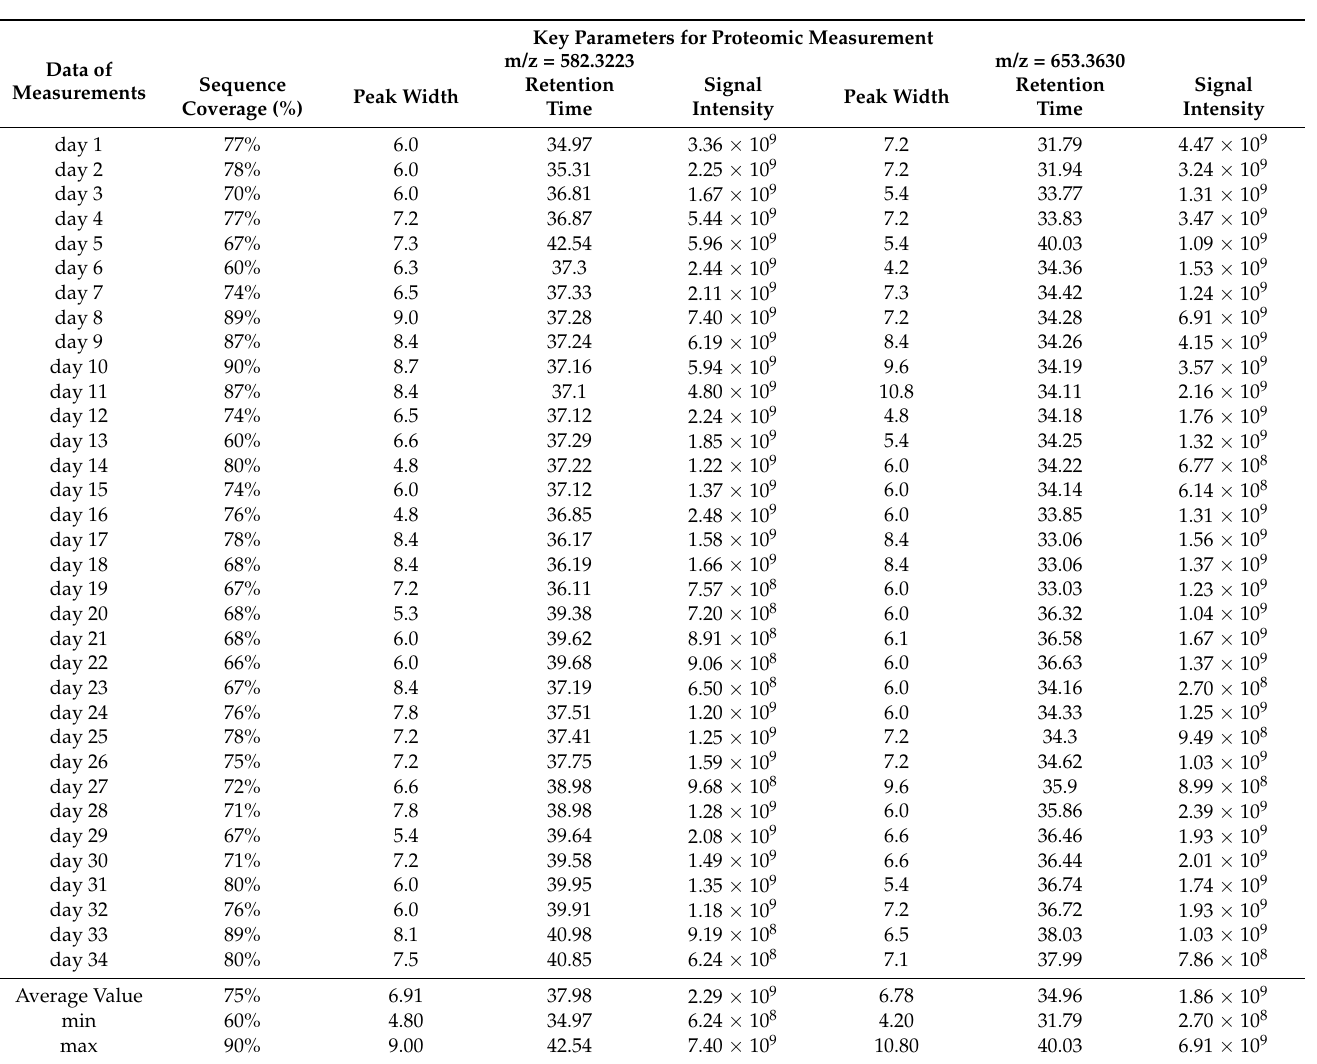
Table 1. Examples of inspected key parameters for proteomic measurement (laboratory data of BSA control sample). Key Parameters for Proteomic Measurement m/z =